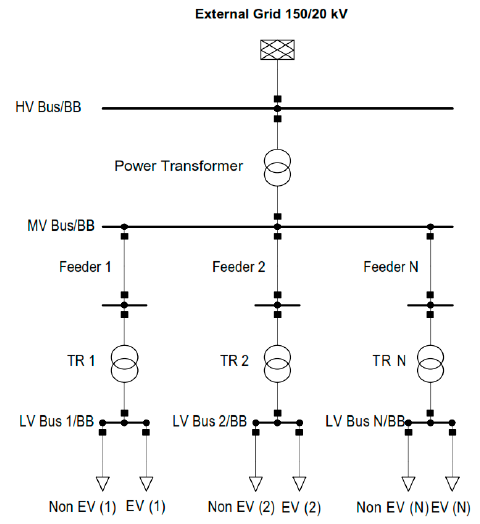
Figure 7. DigSILENT model.